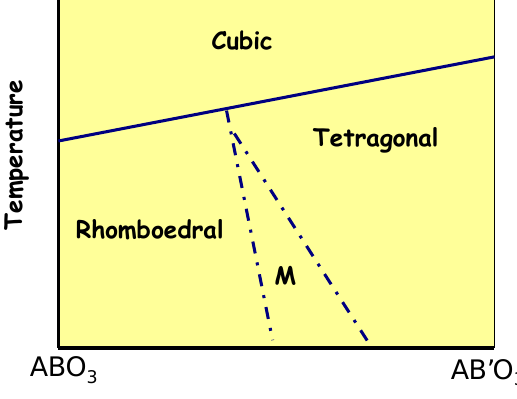
Figure 2 . Phase diagram of a “solid solution” with a morphotropic boundary region